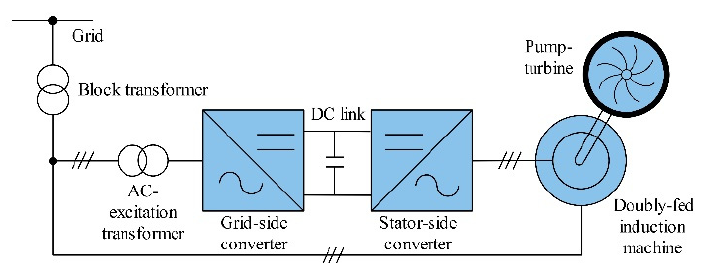
Figure 2. Unit with doubly-fed induction machine.